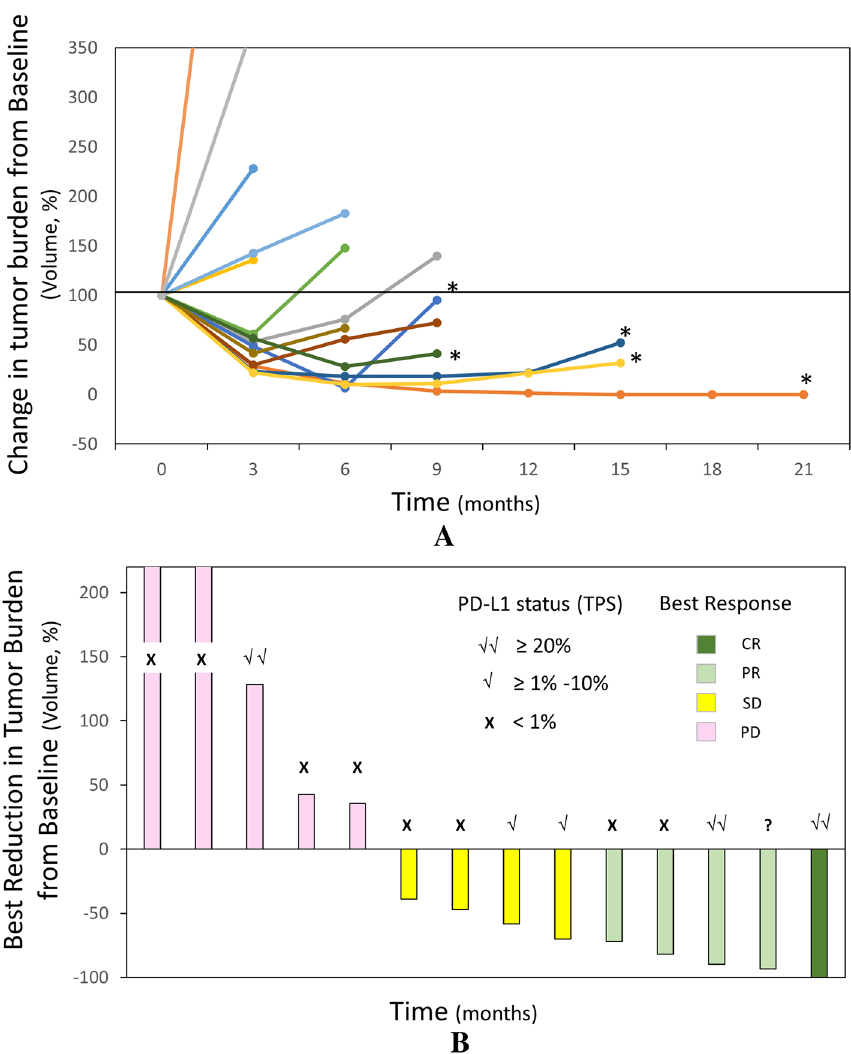
Figure 1. Change of tumor burden in patients after starting treatment. Timeline for change in tumor burden (total volume) based on tumor dimensions provided in patients’ CT scans. *Patients with confirmed partial or complete response. Tumor burden is followed until discontinuation of therapy (n = 13) or complete response (n = 1).